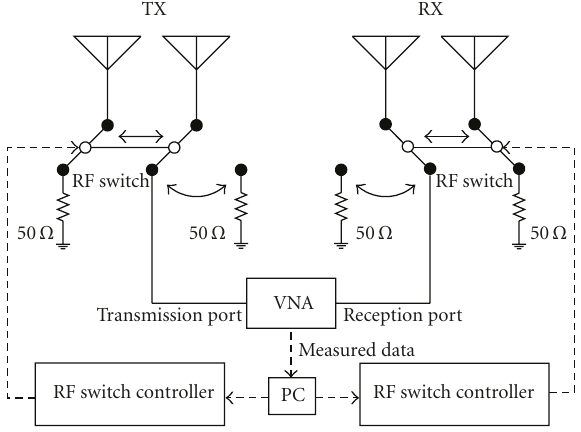
Figure 2: Channel measurement